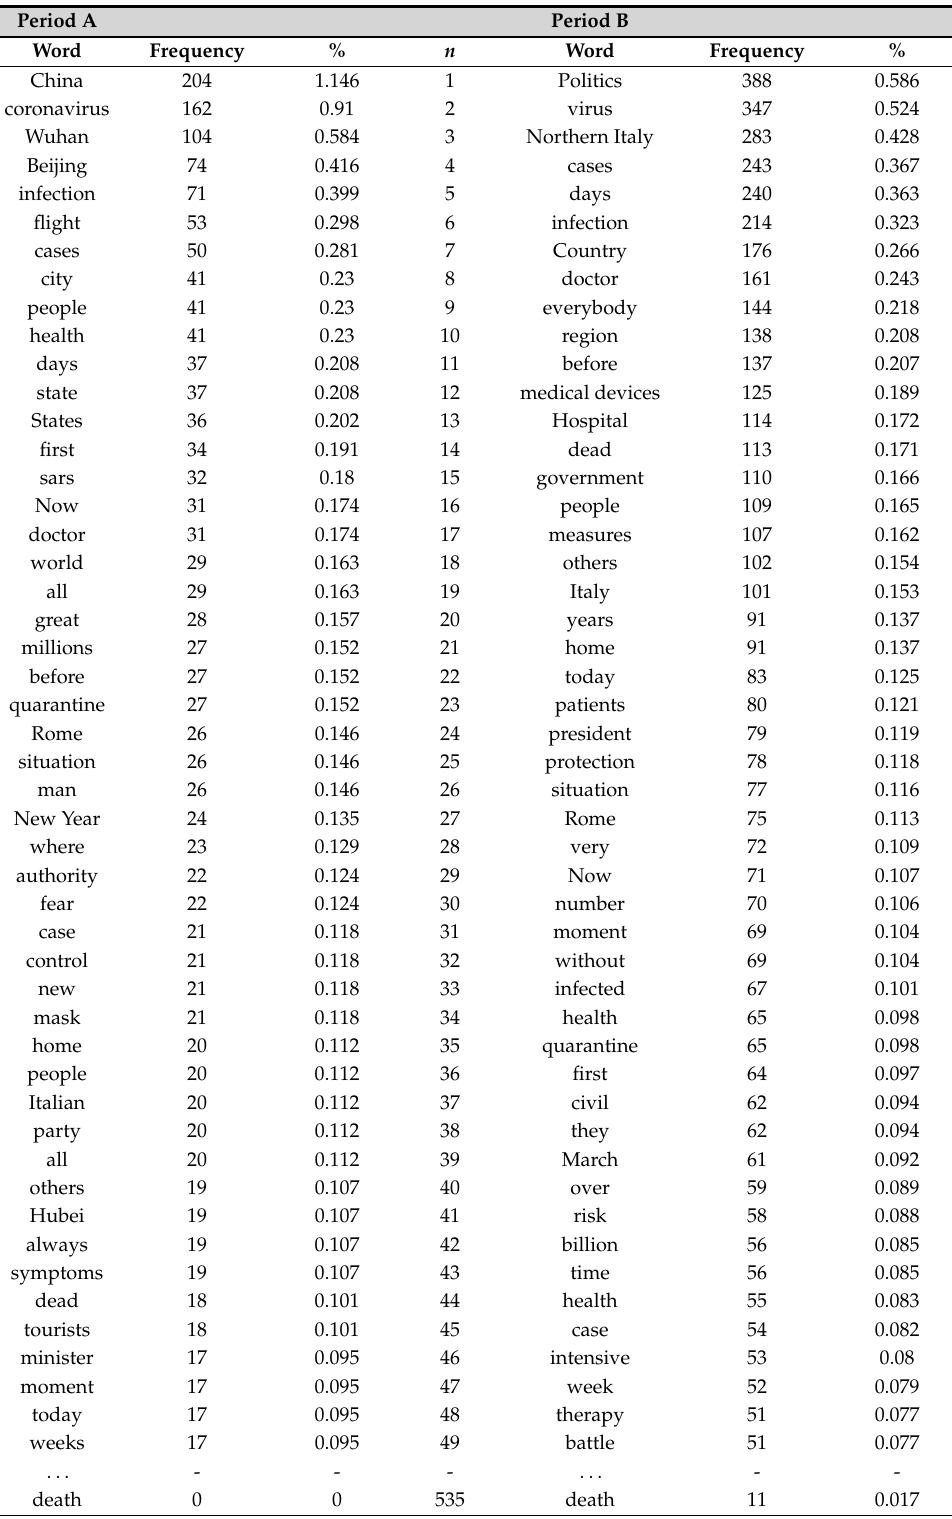
Table 1. Frequencies of the first 25 words in the two